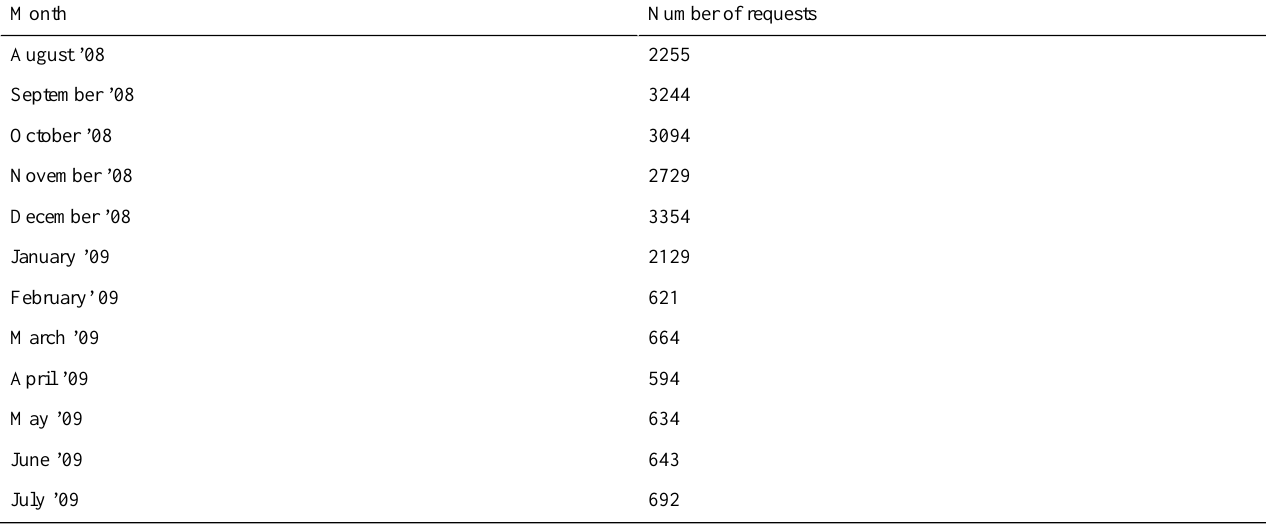
Table 2. Evolution of direct bilirubin test requests.